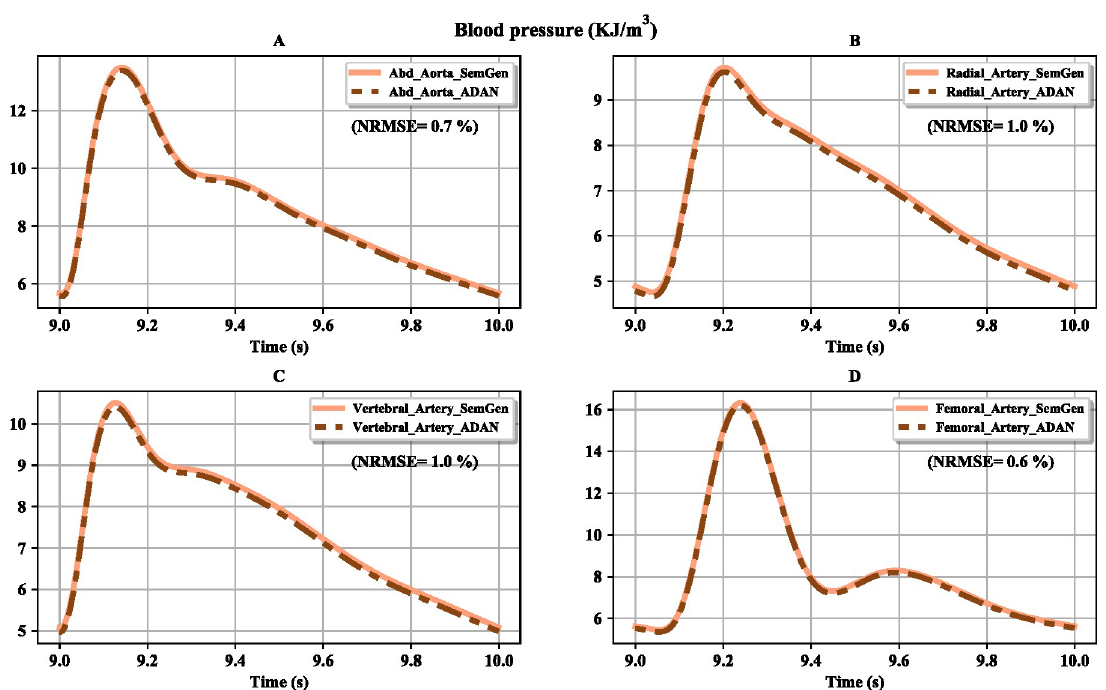
Fig 12. Comparison between the pressures obtained from the ADAN open-loop model and our version of the model. (A) Pressure in the abdominal aorta; (B) pressure in the radial artery; (C) pressure in the vertebral artery; (D) pressure in the femoral artery. The normalised root mean square errors (NRMSE) are represented as